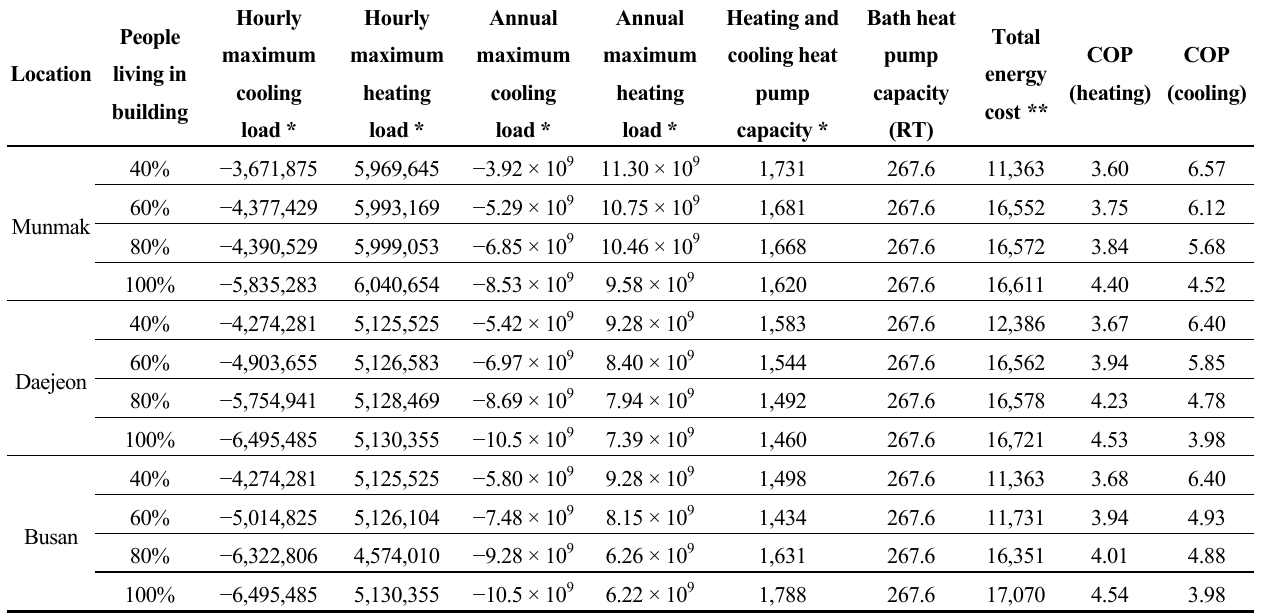
Table 3. Variation of mean ratio of number of people staying in the building to the maximum number of people staying in the building (total floor area 33,000 m 2 , Heat recovery, Night-electricity driven Ground source heat pump